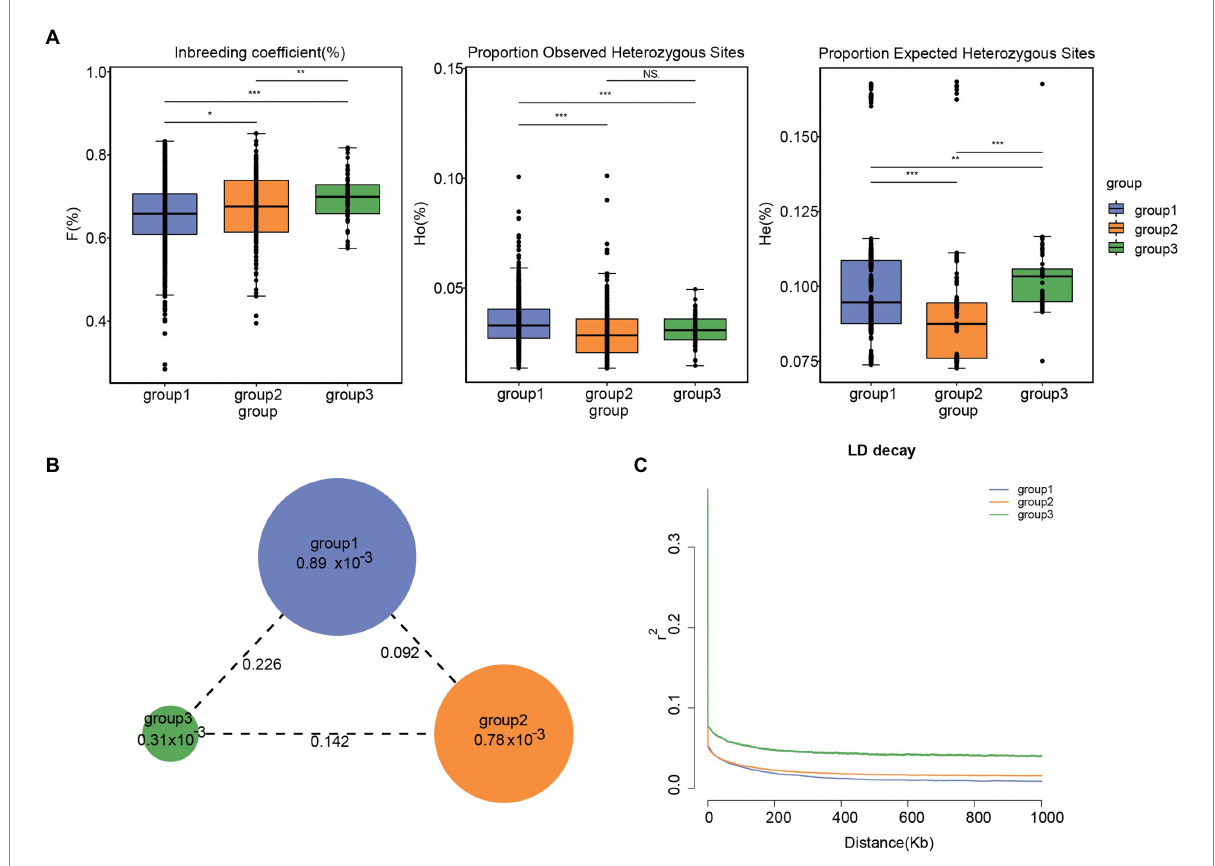
FIGURE 4 (A) Inbreeding coefficient, Proportion Observed Heterozygous Sites(%) and Proportion Expected Heterozygous Sites (%) estimation in tea plant subpopulations. Significances of difference between groups were derived with one-sided t-test. Among them, 0.01 < * p < 0.05; 0.001 < ** p < 0.01; *** p < 0.001. (B) Nucleotide diversity ( θπ ) and genetic differentiation ( F ST ) within different tea plant subpopulations calculated using the sliding- window approach (100 kb windows with 100 kb steps). The circle size represents the mean value of θπ in each subpopulation. The numbers marked between each subpopulation indicate the mean value of F ST . (C) LD decay in different subpopulations. The x-coordinates indicate the distance between bases and the y-coordinates indicate the mean value of the correlation